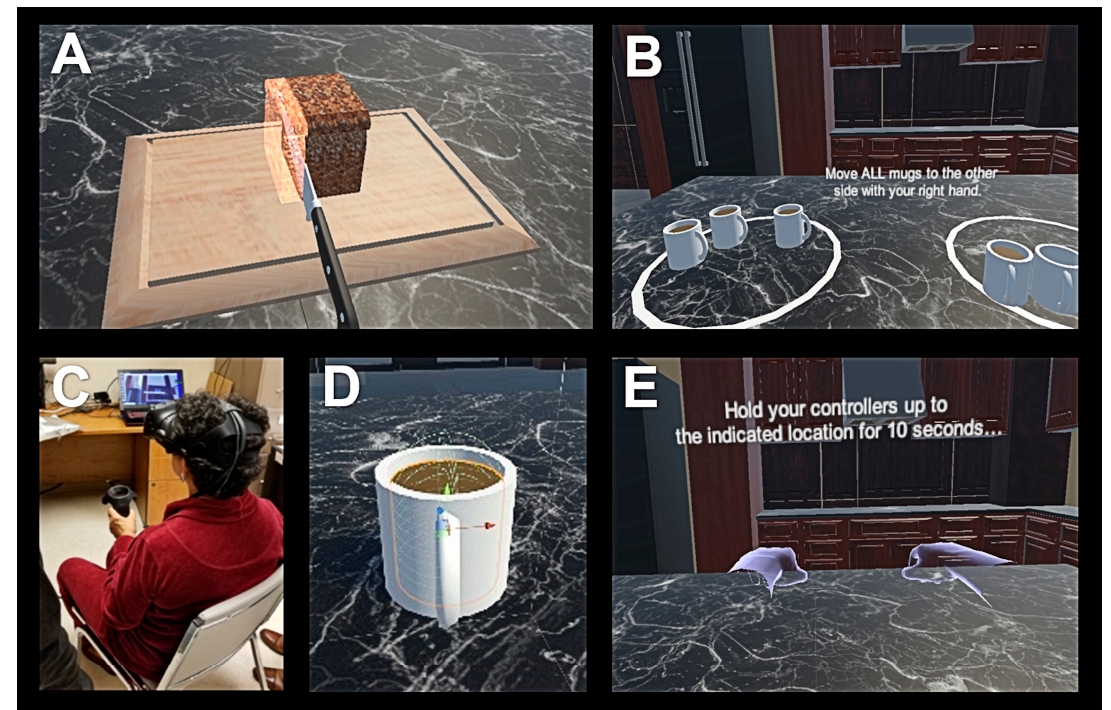
Figure 1. Screen outputs for virtual reality (VR) Time ( A ) and VR activities of daily living (ADL) Score ( B ) tests. Patient undergoing VR Time trial in a seated position ( C ). Close-up view of a mug containing liquid being designed for the VR ADL Score test ( D ). Screen output for the VR Posture Tremor test ( E ).